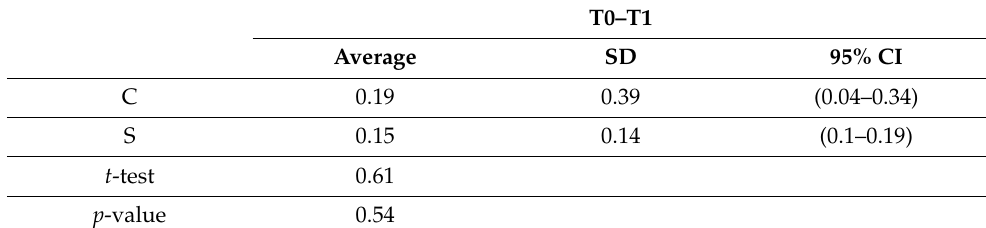
Table 3. Bone loss in crestal and subcrestal implants.